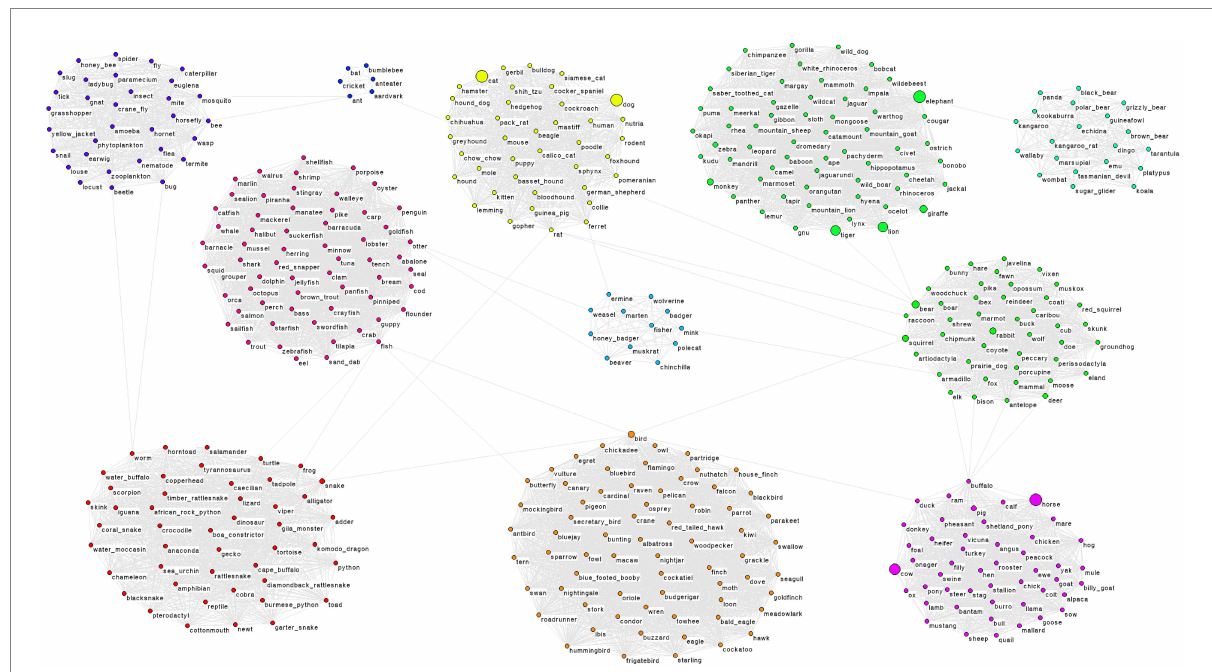
FIGURE 4 Final animal network. Animal names that were not included in the initial graph were placed in the module with their nearest semantic neighbor.